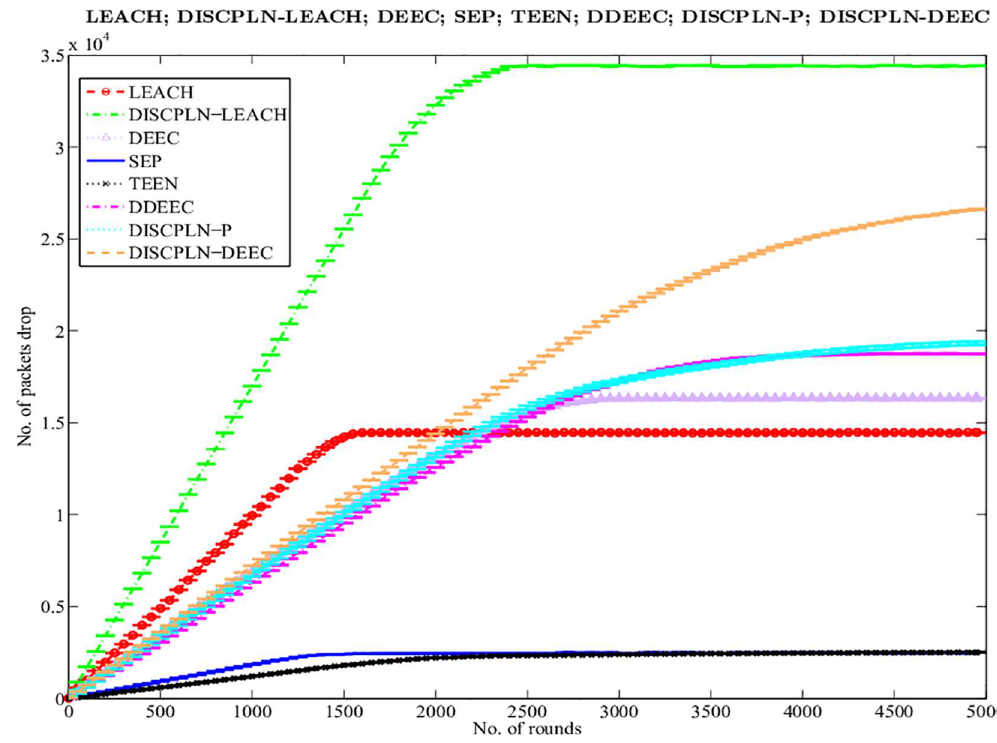
Fig 8. Numberof packet drops for